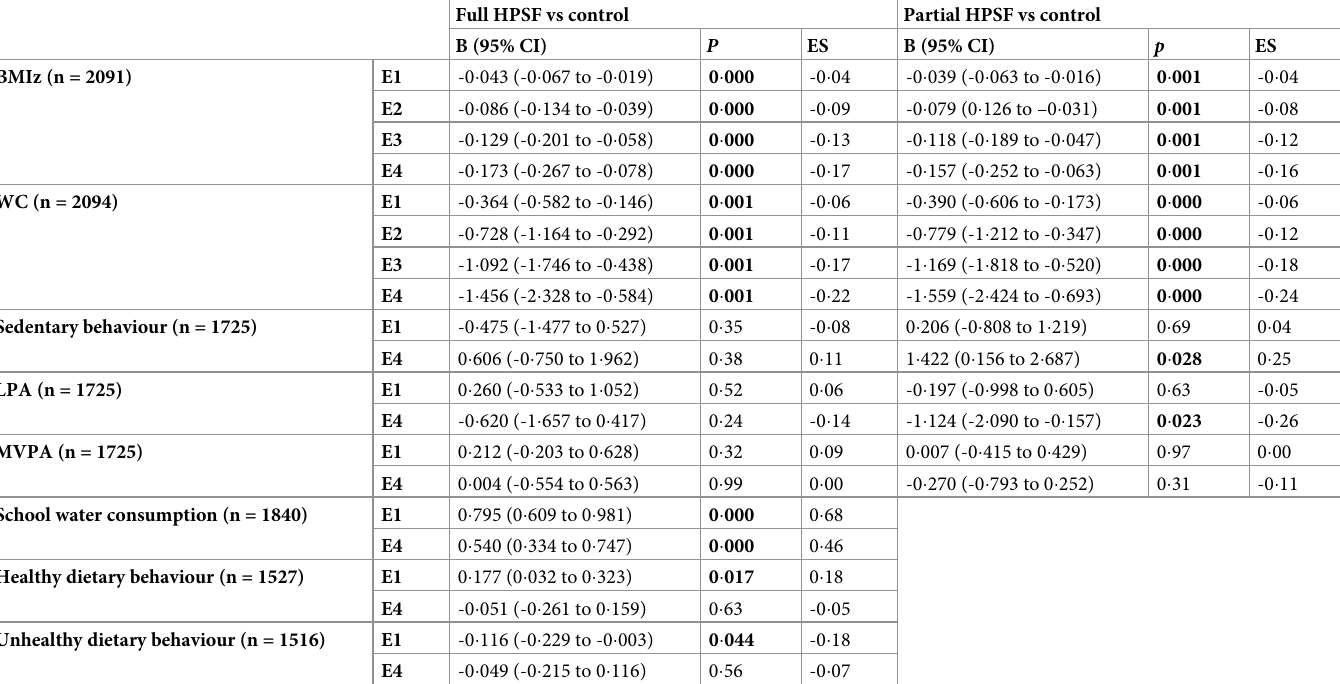
Table 3. Estimated intervention trends on body composition and estimated intervention effects on PA behaviours and dietary behaviours.